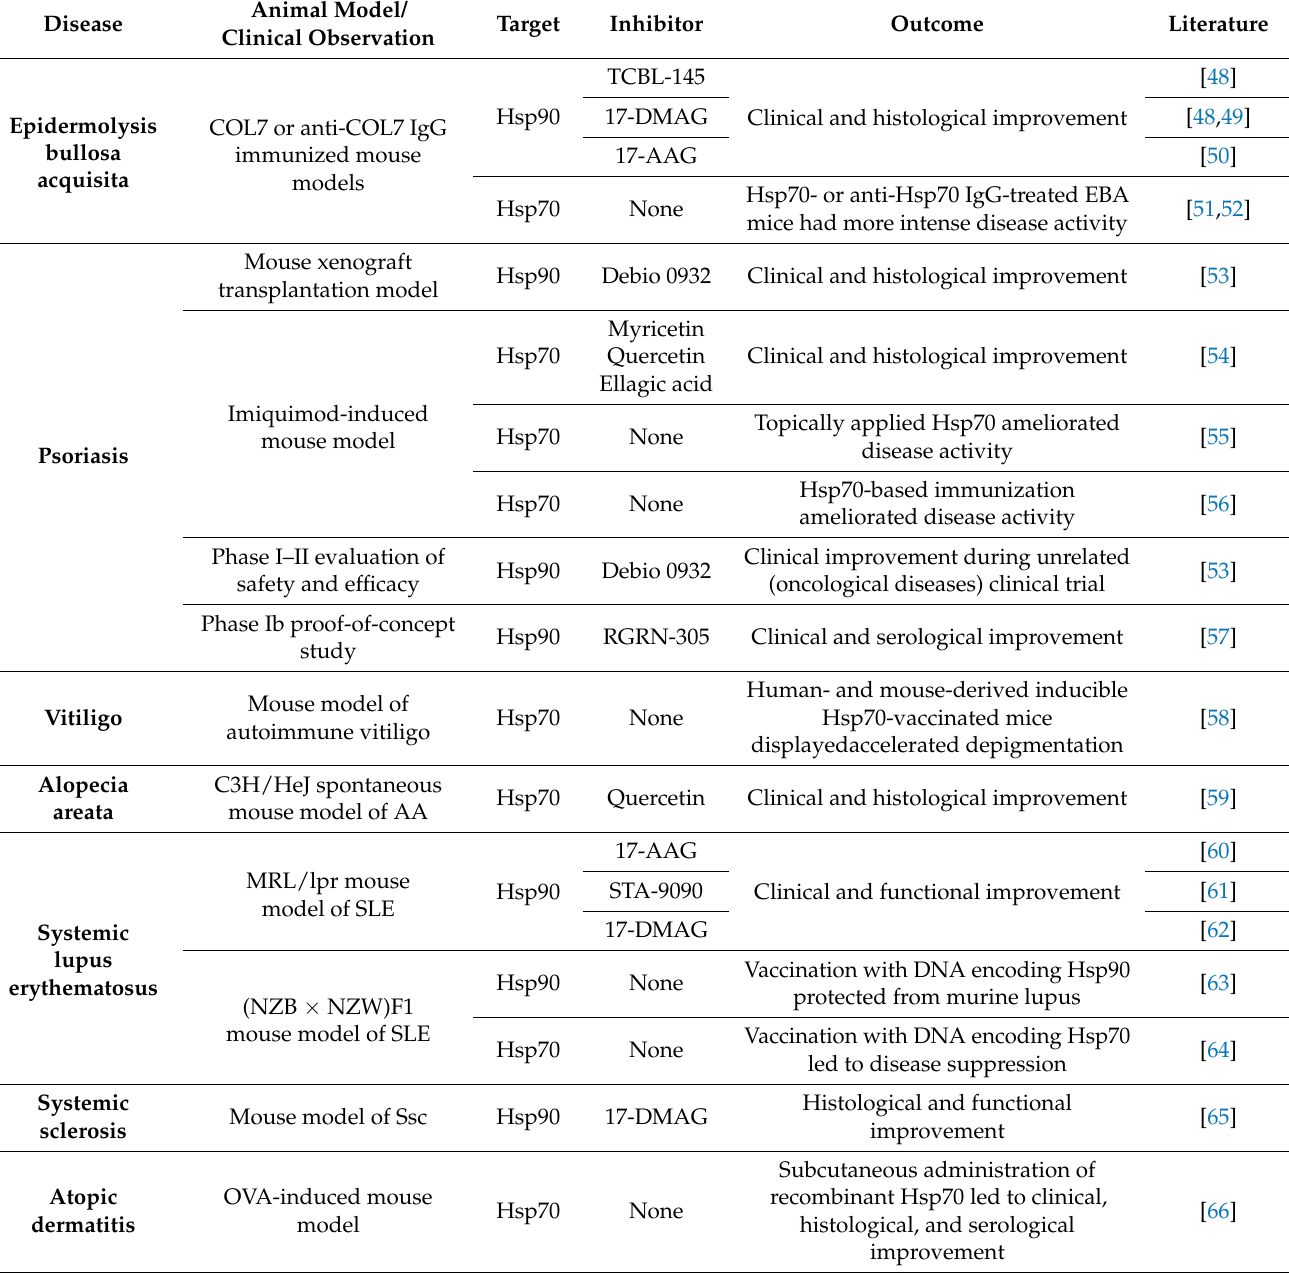
Table 1. Overview of studies targeting Hsp90 or Hsp70 in autoimmune skin diseases based on preclinical and clinical